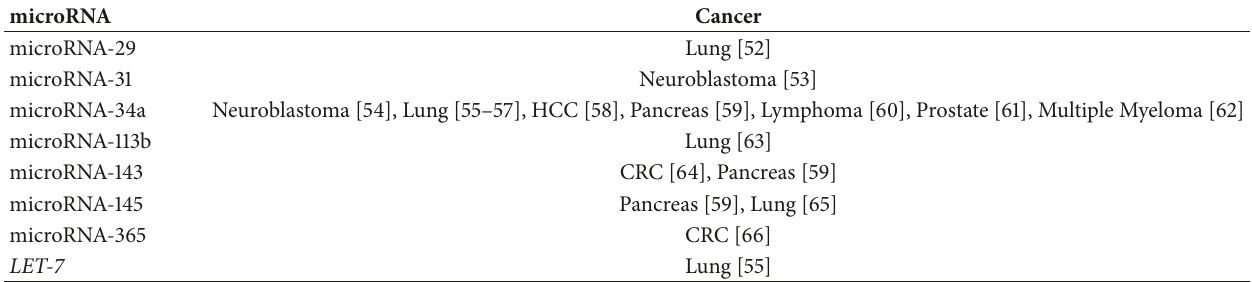
Table 1: MicroRNA replacement therapy with